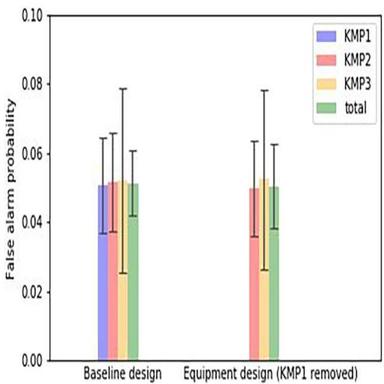
For both the baseline design and the equipment design, the mean of false alarm probabilities at each KMP stays around 0.05.